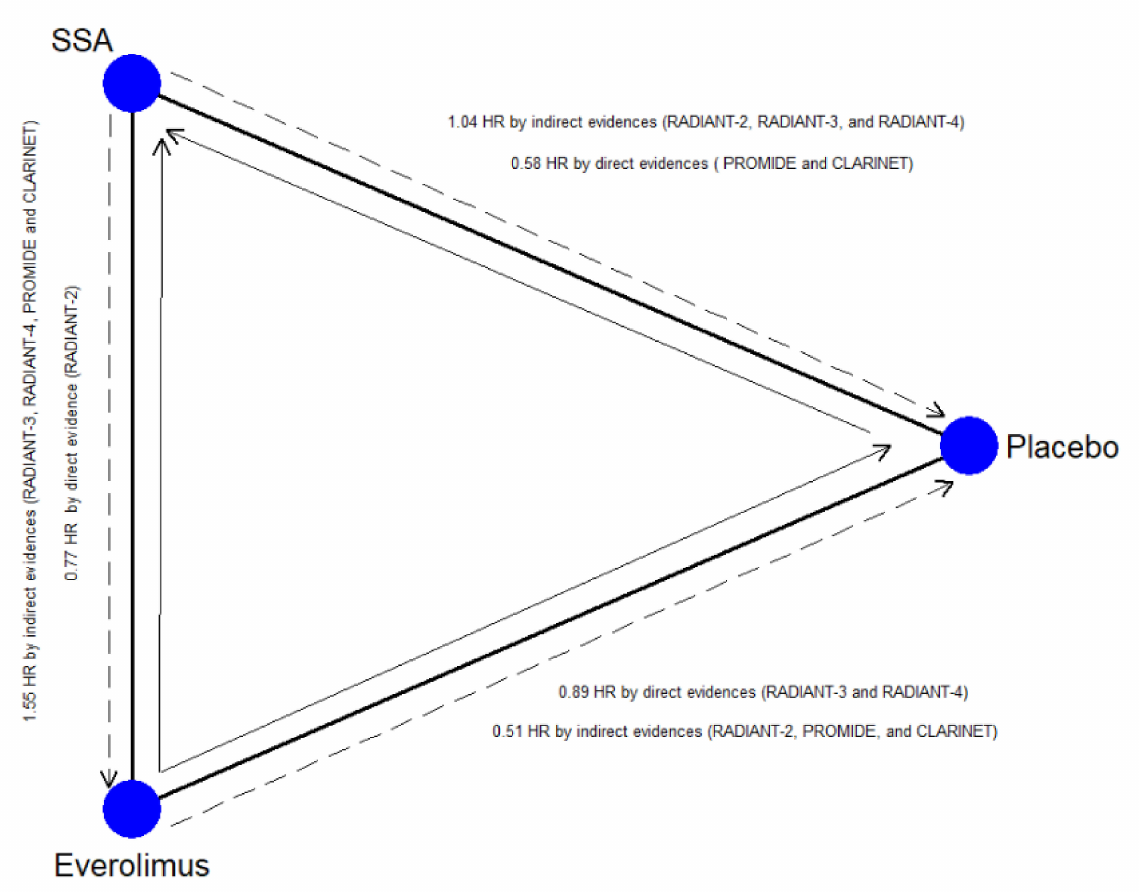
Figure 3. Closed-loop within the network. The blue circles represent the treatment arm while the edges indicate the direct comparison available in the literature SSA = Somatostatin Analog; the dashed arrow represents the indirect estimates; the full arrow the was the direct evidence; the tip of the arrow indicates the therapy more efficacious as Progression-Free